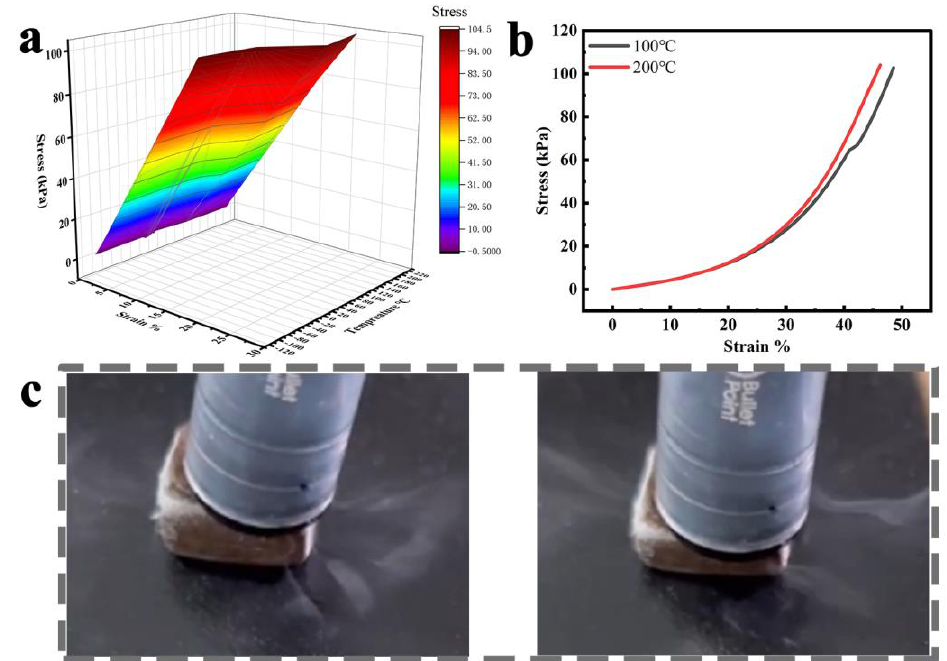
Figure 6. ( a ) 3D surface graphs of the stress dependence on strain and temperature in the compression processes of the elastic wood, exhibiting clear temperature invariance from − 100 to 200 ◦ C. ( b ) Stress– strain curves at 100 ◦ C and 200 ◦ C. ( c ) Schematic representation of the compression process after immersion in liquid nitrogen.